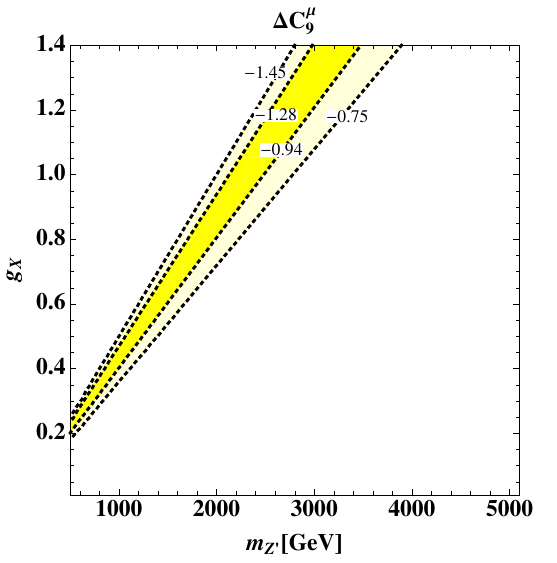
on the m Z 0 - g X plane with x (cid:22) = (cid:0) 1 9 3